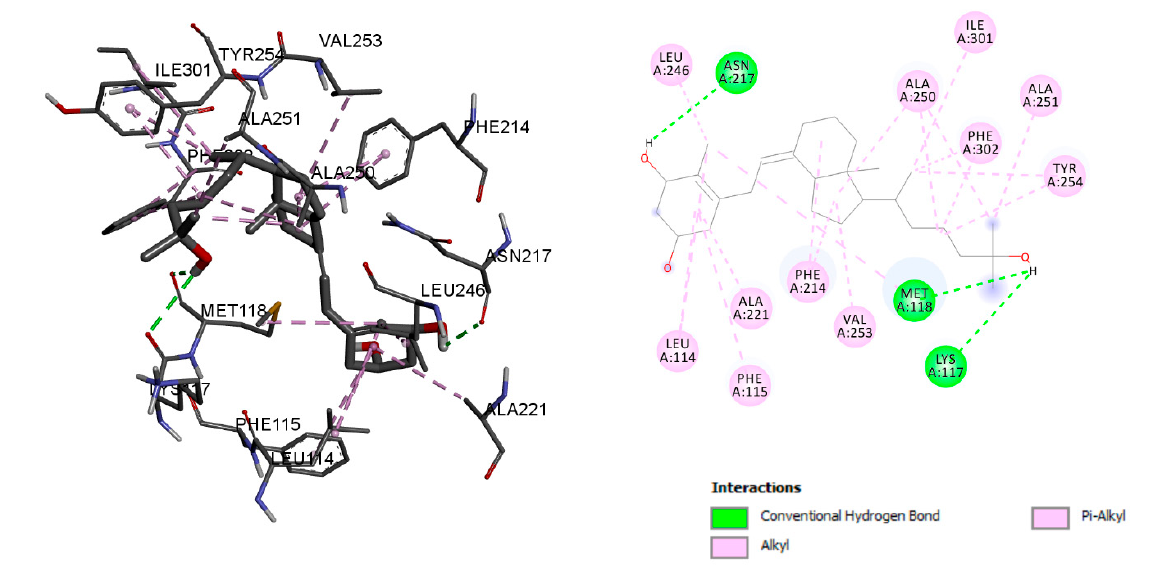
Figure 6. Octocrylene molecular interaction with the enzyme CYP2R1.